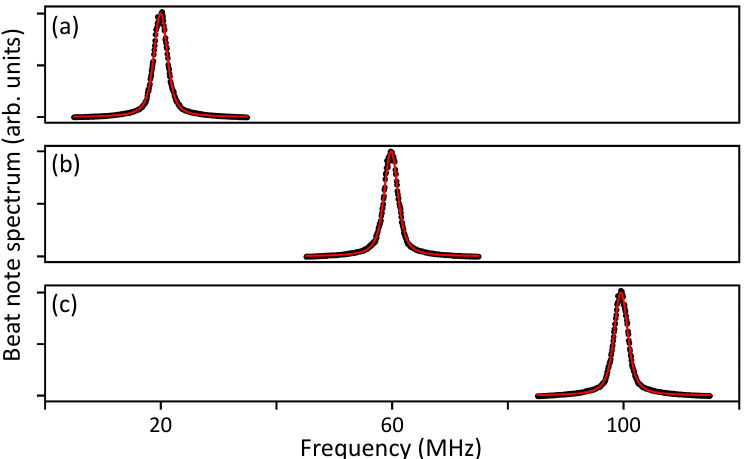
Figure 3. Heterodyne measurement result. Spectrum of beat note of two lasers when the frequency difference is ( a ) 20 MHz, ( b ) 60 MHz, and ( c ) 100 MHz. Black circles are experimental data and red lines are fit with Voigt